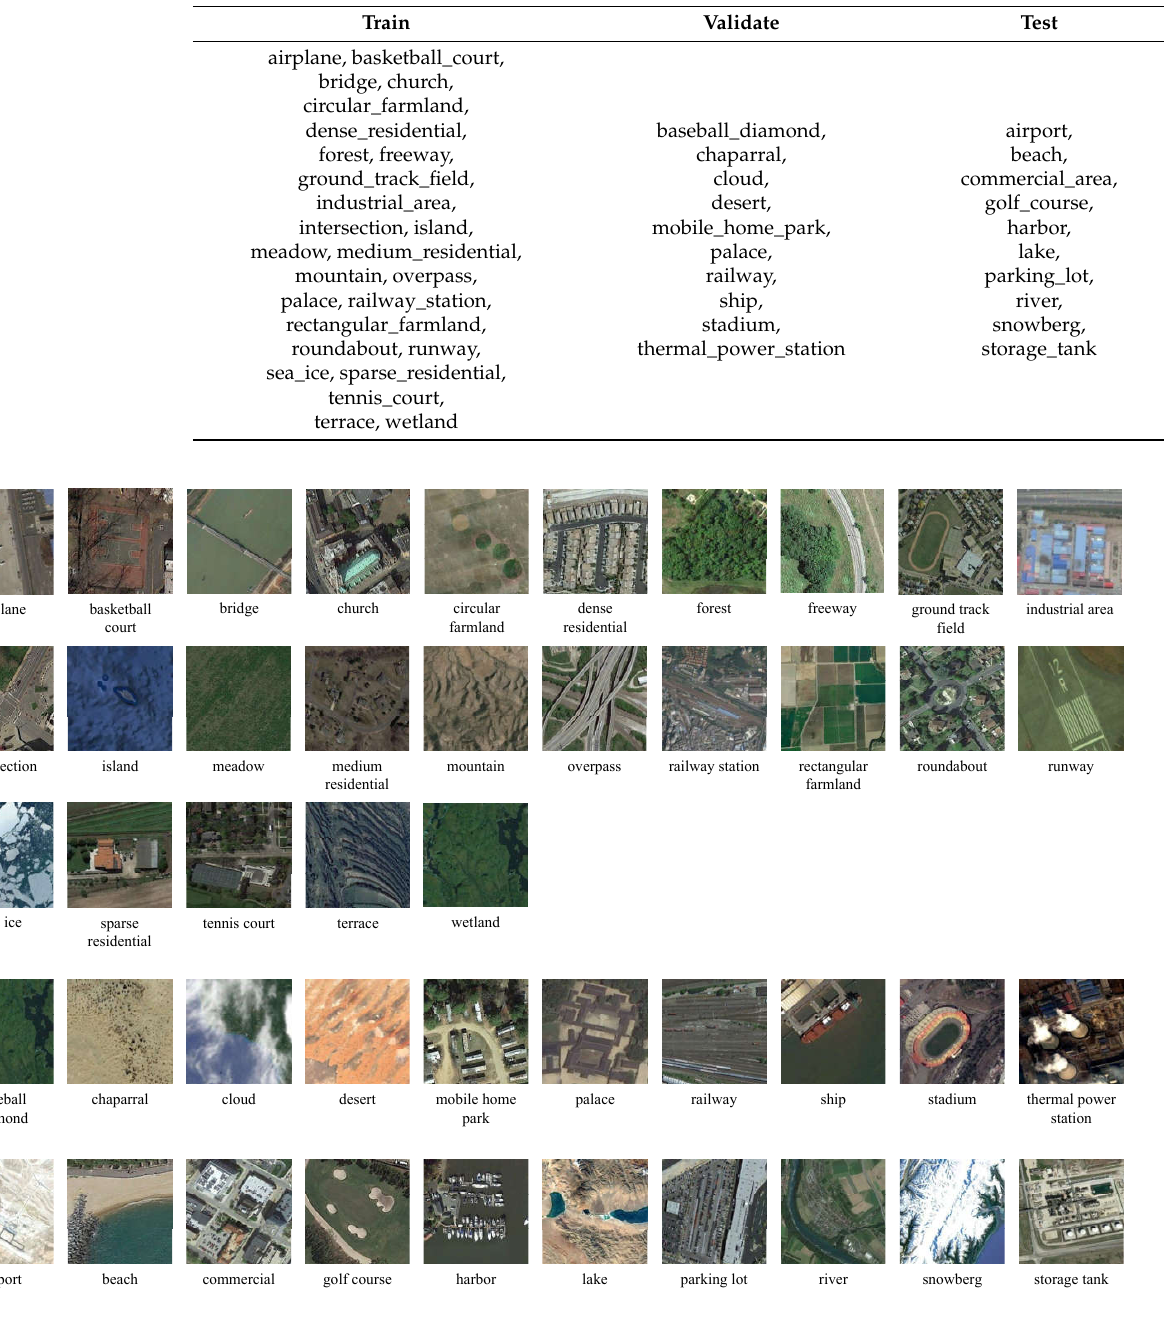
Figure 7. The train, validation, and test partitions of dataset